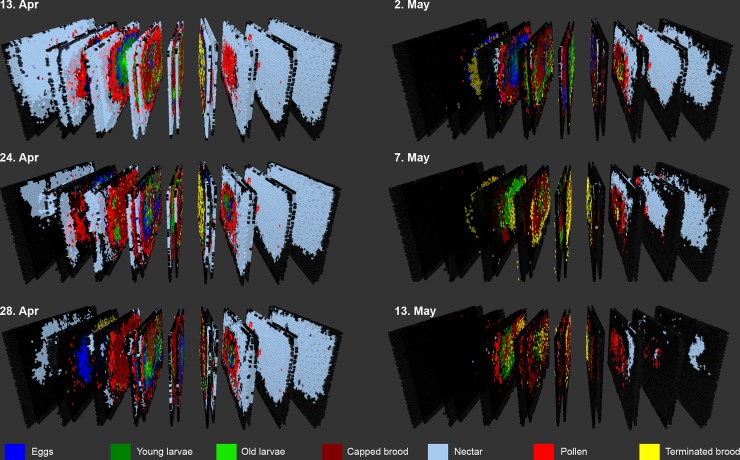
3D representation of the bottom body of a colony hive (hive 17–5).During a period of cold weather nectar and pollen stores were gradually depleted. It can also be seen that brood termination (shown in yellow) was sometimes high, when pollen stores on the same or opposite side of a frame were low (see e.g. 13th and 24th April). Even though pollen was available elsewhere in the hive, it seems that this did not prevent termination.